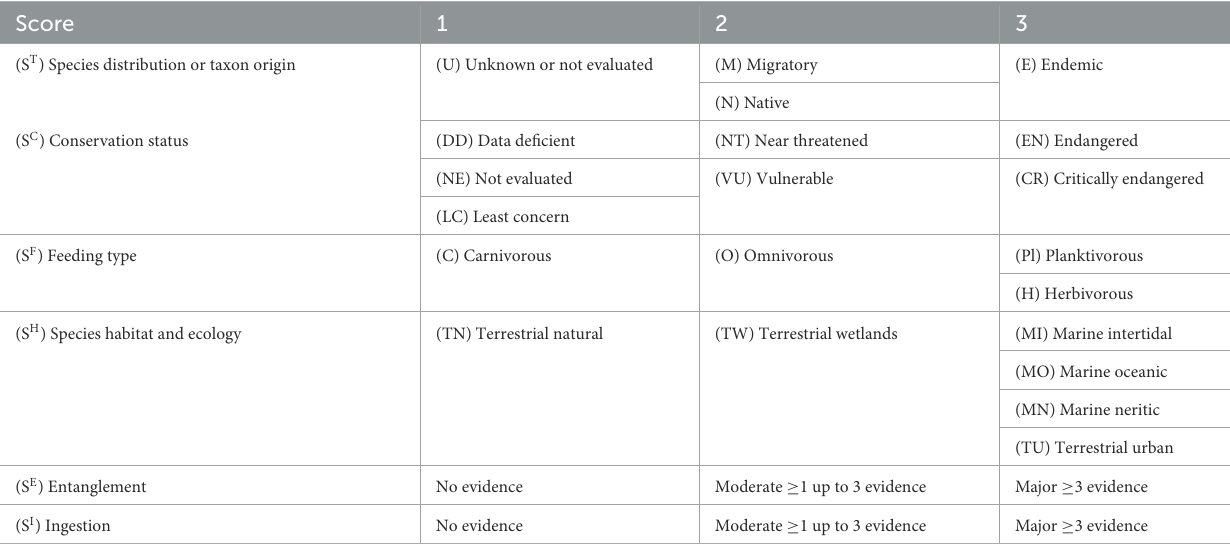
TABLE 2 Scoring criteria for the threat scale on reported species with PP interactions in Galápagos. Score 1